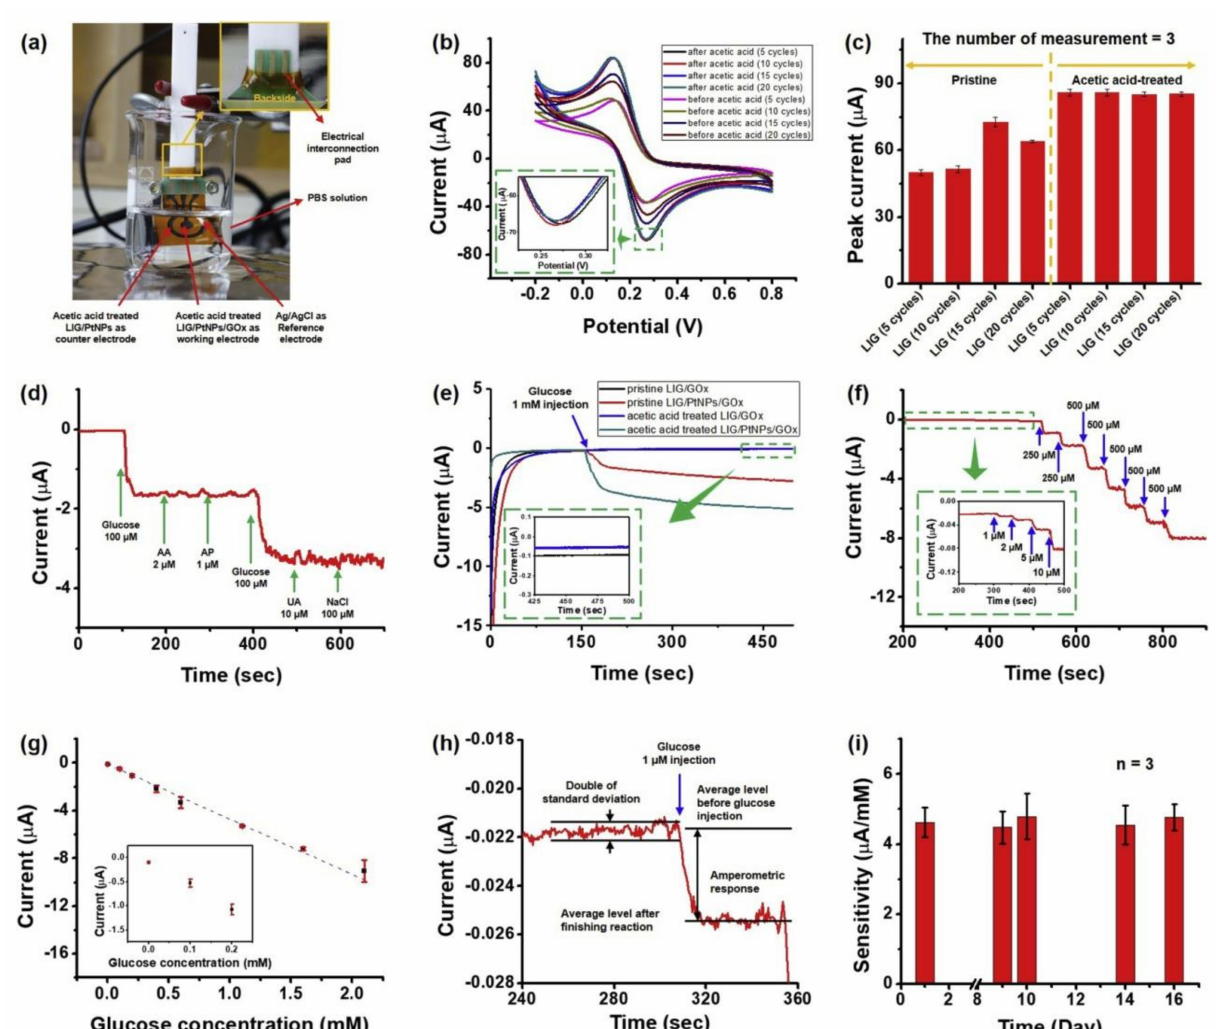
Figure 22. Results of electrochemical characterizations. ( a ) different electrochemical in vitro character- isation test configurations, ( b ) CV conducted in K 3 [Fe(CN) 6 ] solution to compare the redox properties of pristine LIG with PtNPs and acetic acid-treated LIG with PtNPs at a scan rate of 50 mV/s, ( c ) cyclic voltammogram’s cathodic peak current, ( d ) urrent response of glucose and interferences such as AP, AA, NaCl, and UA, ( e ) current responses of different LIG − based electrode samples, ( f ) The current response of the various glucose concentration from ultra-low glucose levels. ( g ) Linear regression functional curve. ( h ) Current response under 1 µ M glucose injection. ( i ) Daily variation of the sensitivity of the as-produced acetic acid-treated LIG/PtNPs/GOx electrode. (Reproduced from [471] with permission. Copyright 2020, Elsevier, Amsterdam, The